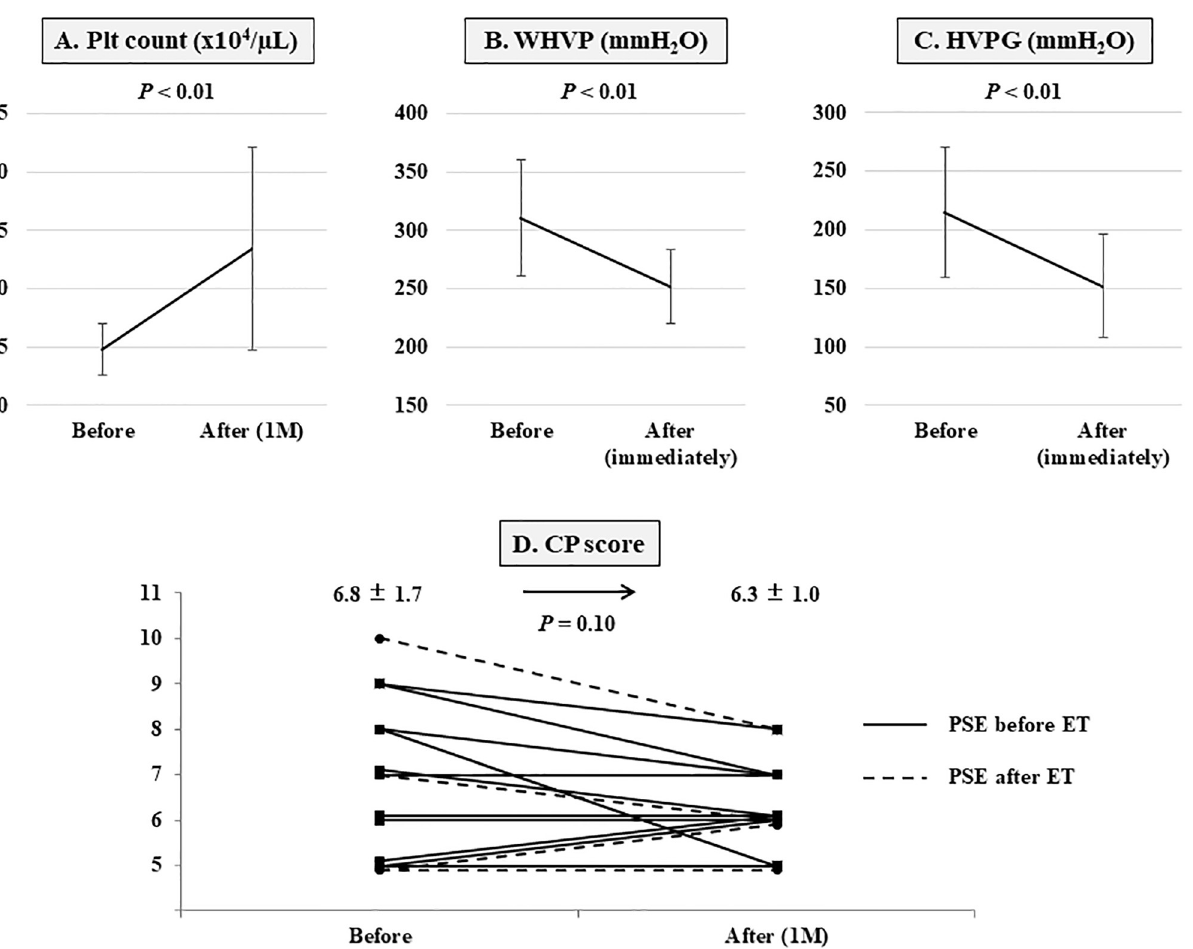
Fig 3. Hematological, hemodynamic, and hepatic functional changes in 15 patients who underwent partial splenic embolization (PSE) and endoscopic treatment. (A), The mean platelet count increased significantly from 4.8 × 10 4 / μ L (standard deviation [SD] = 2.2) pre-PSE to 13.4 × 10 4 / μ L (SD = 8.7) at 1-month post-PSE ( p < 0.01). Splenic artery embolization significantly reduced the (B) mean wedged hepatic venous pressure from 310.5 mmH 2 O (SD = 49.4) to 251.5 mmH 2 O (SD = 31.8) ( p < 0.01), and the (C) mean hepatic venous pressure gradient from 214.5 mmH 2 O (SD = 55.5) to 152.0 mmH 2 O (SD = 44.0) ( p < 0.01), which were measured before and immediately after PSE. (D) The mean Child-Pugh (CP) score decreased from 6.8 (SD = 1.7) pre-PSE to 6.3 (SD = 1.0) at 1-month post-PSE ( p = 0.10); the changes in the CP classifications at 1-month post-PSE were as follows: CP class A to CP class A ( n = 7), CP class B to CP class A ( n = 3), CP class B to CP class B ( n = 4), and CP class C to CP class B ( n = 1). Plt, platelet; WHVP, wedged hepatic venous pressure; HVPG, hepatic venous pressure gradient; CP, Child-Pugh; PSE, partial splenic embolization; ET, endoscopic treatment; 1M, 1